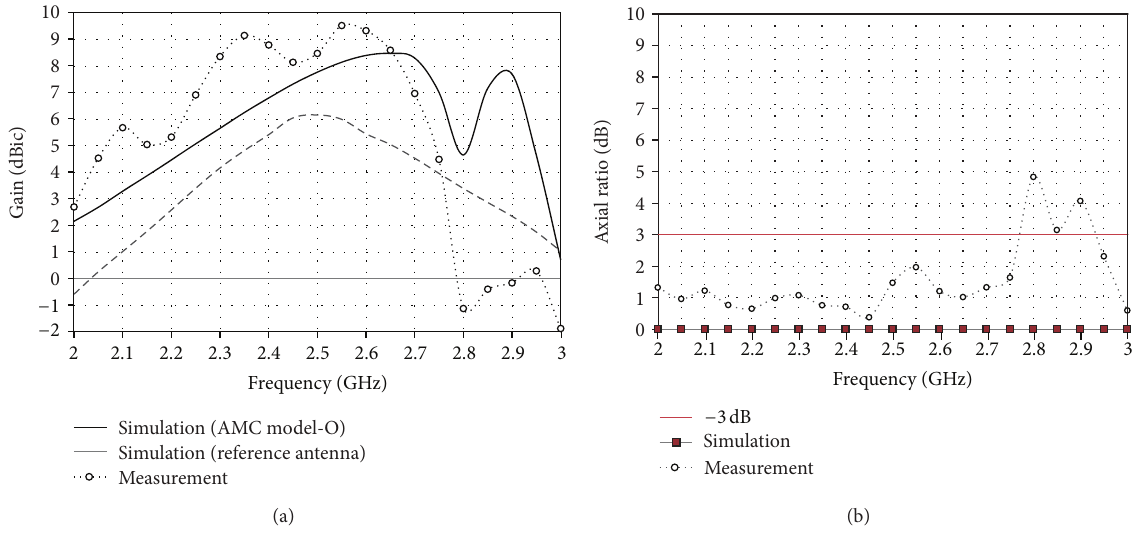
Figure 11: The measured gain and axial ratio as a function of frequency. (a) Gain. (b) Axial